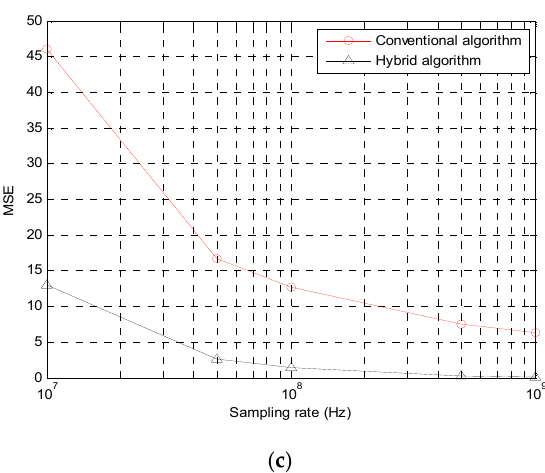
Figure 15. MSE curves for the estimated MS locations based on the proposed hybrid algorithm and the conventional algorithm, of the second scenario for ( a ) the first case, ( b ) the second case, and ( c ) the third case, for the second set.